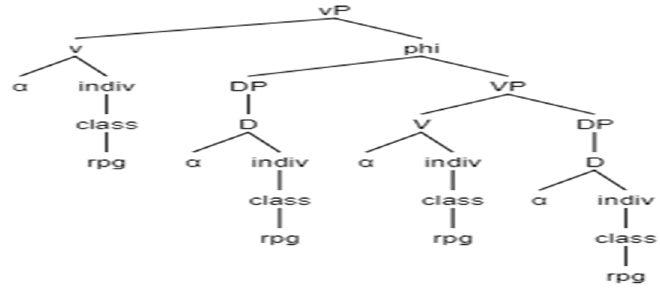
Figure 11. V inherits the ONs from